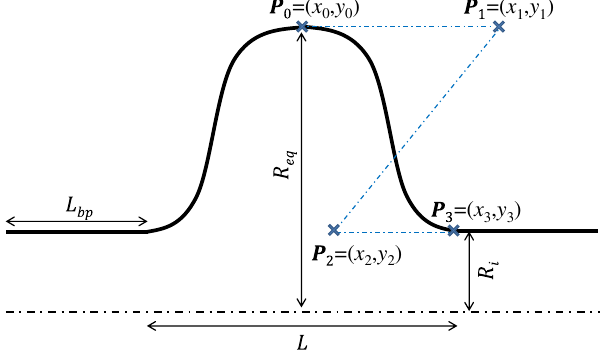
FIG. 12. Parametrization of a single-cell B´ezier cavity. The cross section is symmetric, and half of the curved part of the boundary is a B´ezier curve.